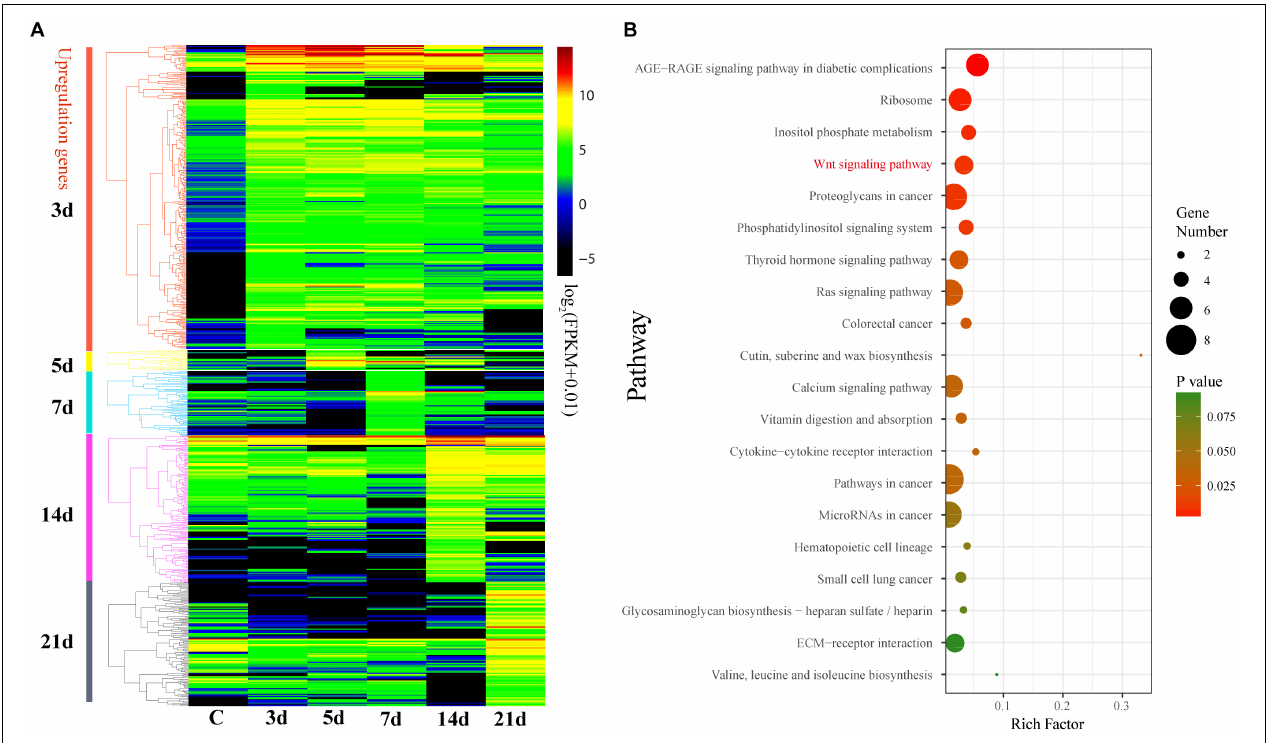
FIGURE 4 | Differential expression analysis of genes during intestinal regeneration. (A) Expression profiles of the DEGs at different intestinal regeneration time points: 0 (C), 3 day (3d), 5 day (5d), 7 day (7d), 14 day (14d), 21 day (21d). DEGs are divided into five groups that significantly expressed at 3d (3d versus C), 5d (5d versus 3d), 7d (7d versus 5d), 14d (14d versus 7d), and 21d (21d versus 14d). (B) Significantly enriched pathways of DEGs that significantly upregulated at 3d. RichFactor is the ratio of the number of DEGs in this pathway term to the number of all genes in this pathway